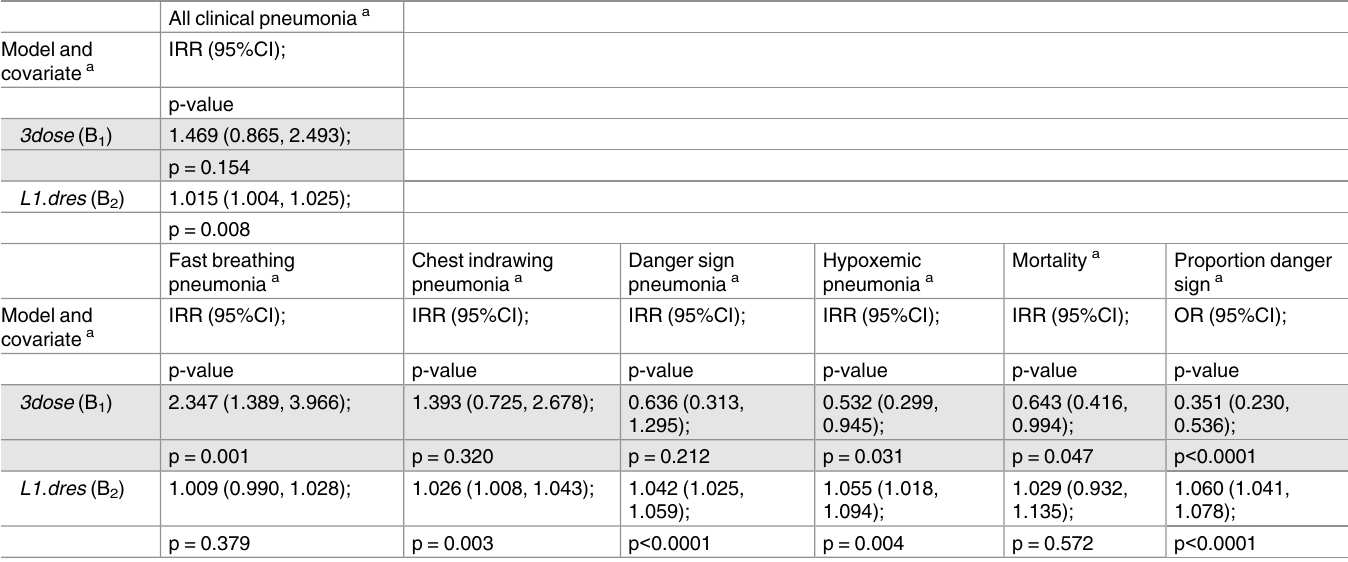
Table 4. Time-series regression results with the association of 76% three-dose PCV13 coverageon pneumonia outcomes highlighted All clinical pneumonia